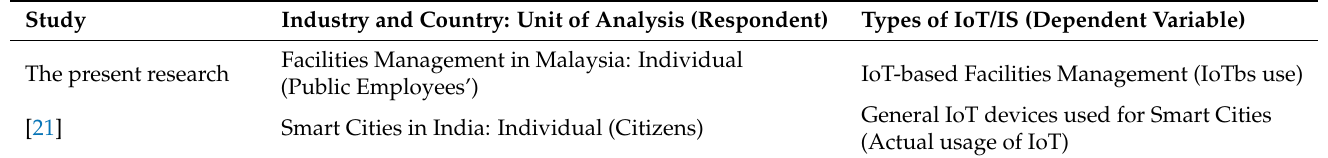
Table 8. A comparison between the present research and prior research of IoT success—study